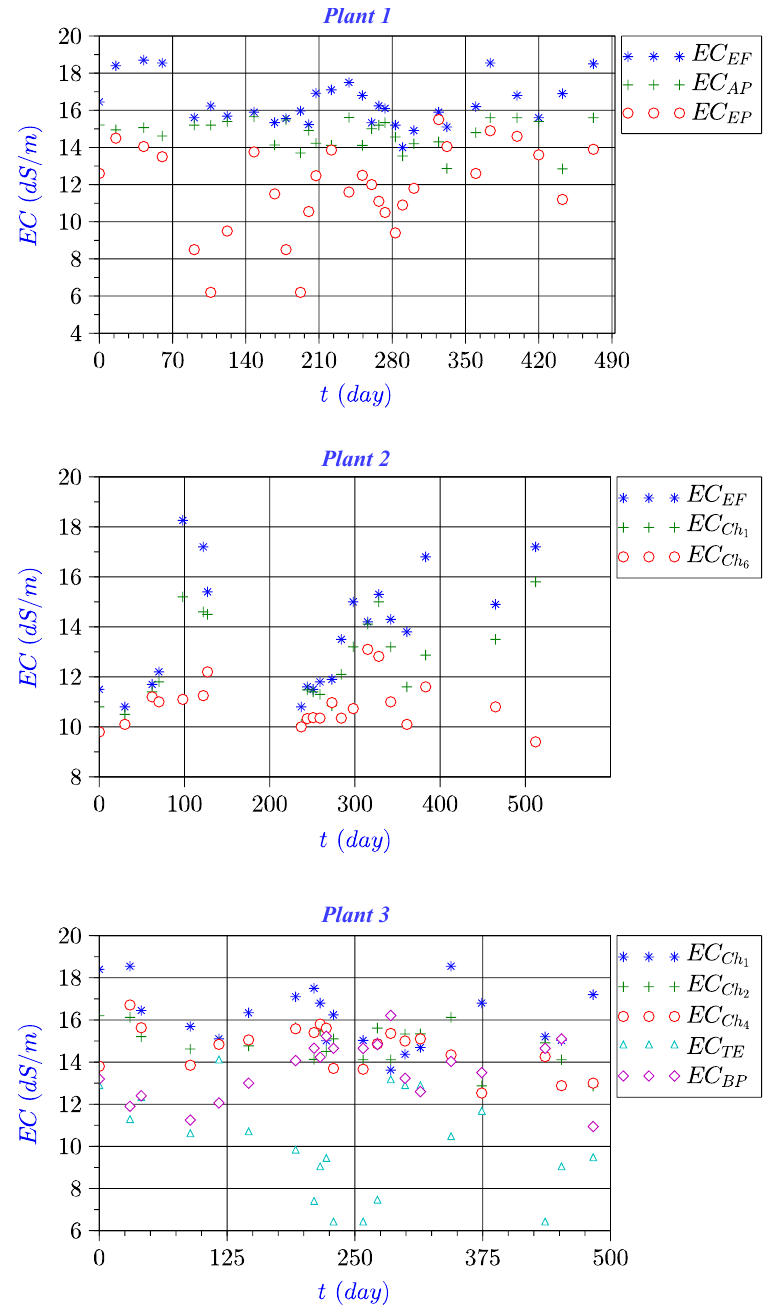
Figure 12. EC results for plant 1, 2, and